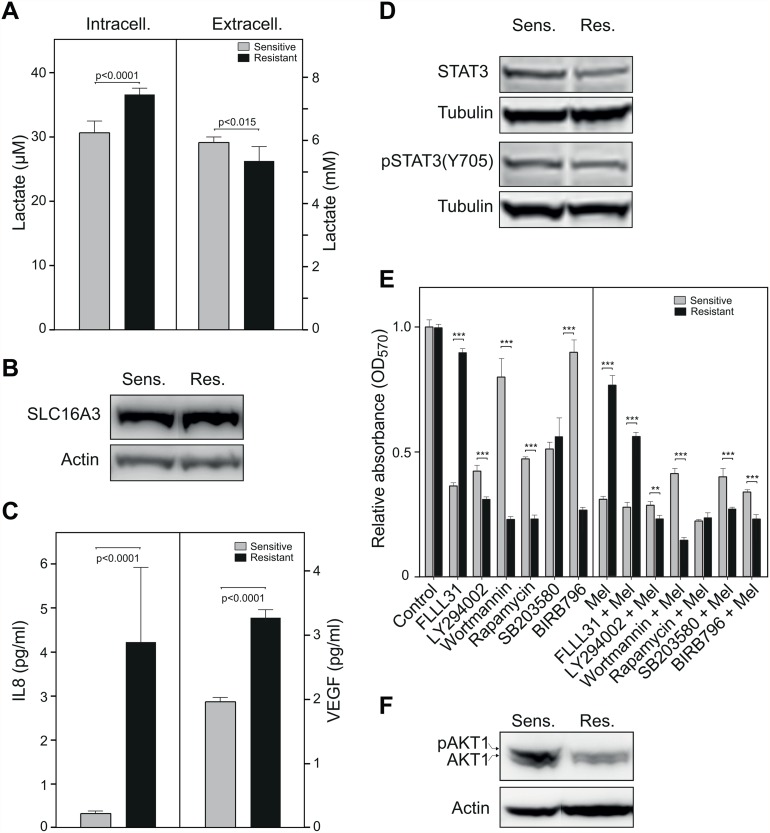
Lactate accumulates in melphalan resistant cells and may mediate increased IL8- and VEGF signaling.(A), Bar diagrams demonstrating significantly increased lactate accumulation in melphalan-resistant cells (left panel), and significantly lower lactate in the extracellular medium (right panel). (B), Western analysis revealed no significant change in expression of the major lactate exporter SLC16A3 (C), Bioplex cytokine profiling demonstrated markedly elevated synthesis of IL8 (left panel) and VEGF (right panel) in the melphalan-resistant cells. (D), Western analysis demonstrated no induced activation of STAT3 in the melphalan resistant cells as probed with anti-pSTAT3 (Y705 antibody). (E), Bar diagram illustrating the effects of various inhibitors targeting STAT3 (FLLL31, 3μM), PI3-kinases (LY294002, 10 μM, wortmannin, 2 μM, rapamycin, 5nM) and p38 MAP kinases (SB203580, 10 μM, BIRB796, 10 μM). (F), Western analysis demonstrating down-regulation of p-AKT1 and AKT1 in the melphalan-resistant cells.